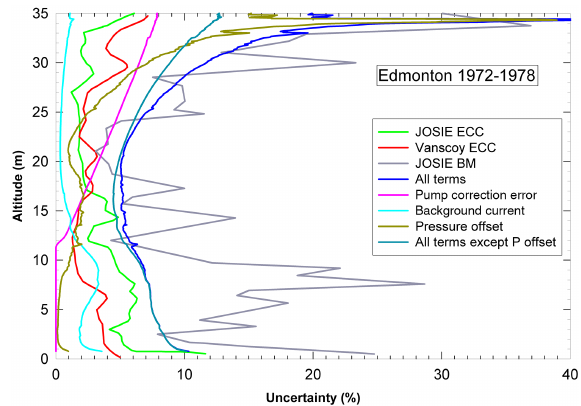
Figure 5. Average estimated uncertainty of Brewer–Mast soundings at Edmonton, showing contributions from selected sources. The to- tal uncertainty without the contribution from radiosonde pressure offsets is also shown, to facilitate comparison with the JOSIE and Vanscoy intercomparison uncertainty estimates, which were refer- enced to a common pressure measurement. The uncertainty in the VIZ radiosonde pressure measurement dominates the calculated un- certainty above about